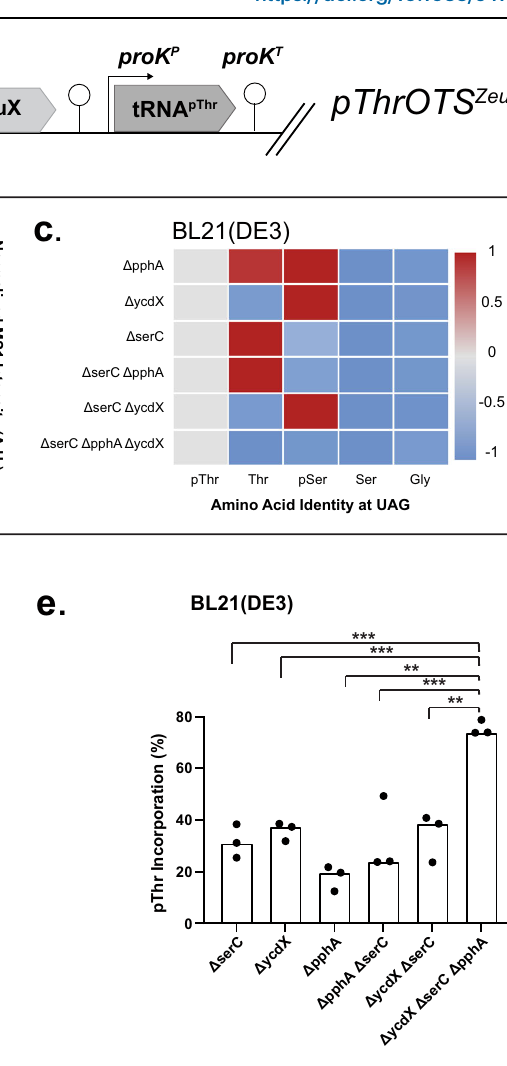
READ reporter in either d C321. Δ A.exp or e BL21(DE3). Signi fi cance determined by two-tailed student ’ s T -test (equal variance) noted by * p <0.05, ** p <0.01, *** p <0.001ornon-signi fi cant(NS) P valuesfromleft( Δ serC)toright( Δ ycdX Δ serC) for( d ):6.75E − 04, 4.76E − 05, 9.11E − 06, 1.1E − 04and e 4.34E − 04,1.16E − 04, 6.08E-05, 7.47E − 03, 1.88E −